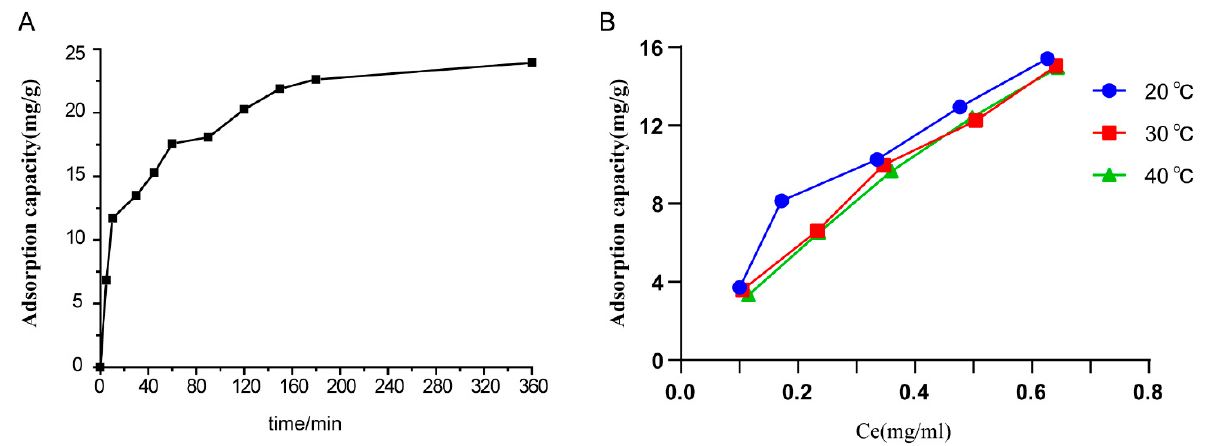
Figure 2. Adsorption behavior of TFC on microporous resin. ( A ) Adsorption kinetics curve of the TFC on D-101 resin. ( B ) Adsorption isotherms of the TFC on D101 resin at 20 °C, 30 °C and 40 °C. Ce, the absorption equilibrium concentration of analyte in the solution.